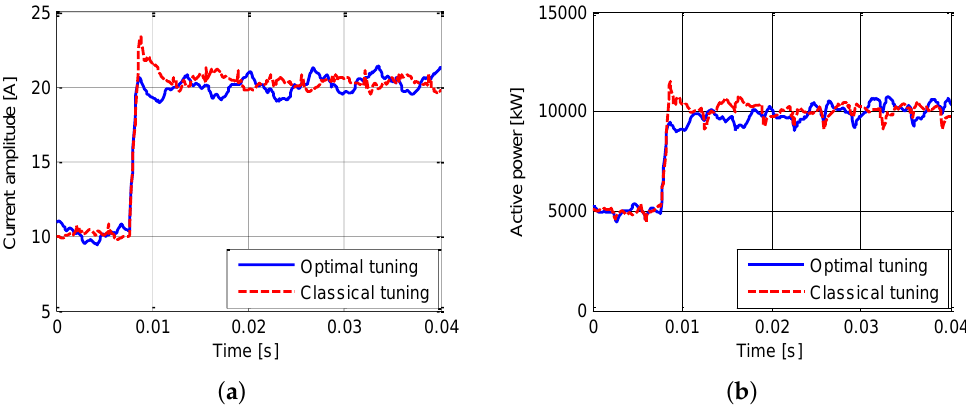
Figure 14. Comparison of the proposed optimal tuning and the classical tuning under a step in the active power reference: ( a ) current amplitude; and ( b ) active